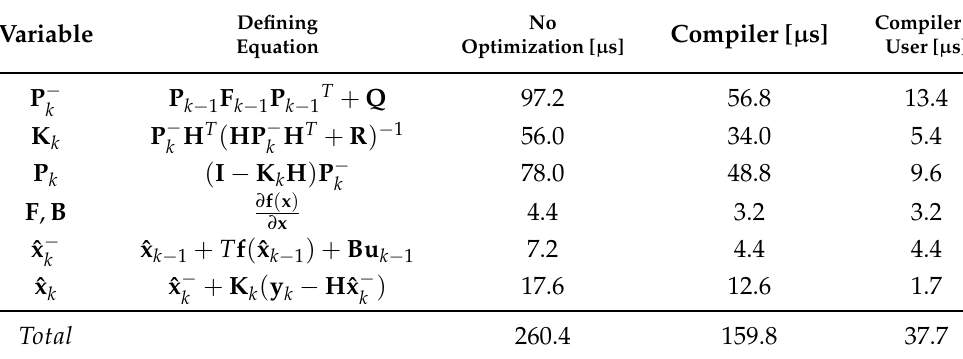
Table 2. Table 2. Comparison of the EKF steps execution